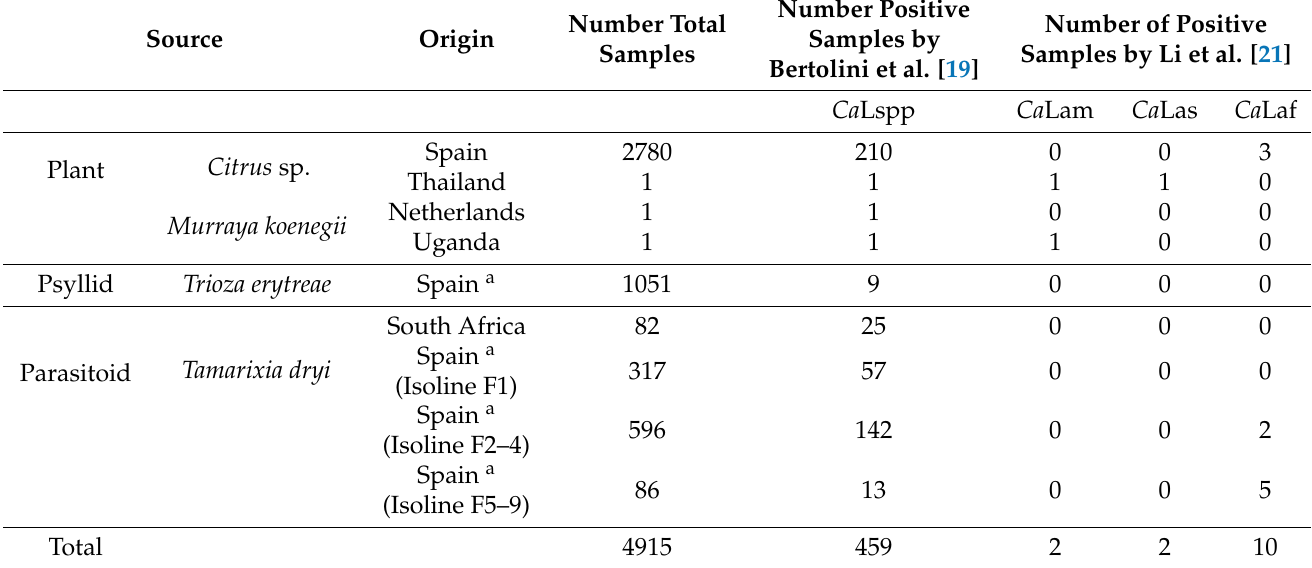
Table 1. Analysis of plant and insect samples in the period 2009–2018 for the detection of huanglongbing (HLB)-associated bacteria by the real-time PCR protocols described by Bertolini et al. [19] and Li et al. [21]. Number Positive Number Total Number of Positive Source Origin Samples by Samples Samples by Li et al. [21] Bertolini et al. [19] Ca Lspp Ca Lam Ca Las Ca Laf Spain Plant Citrus sp.